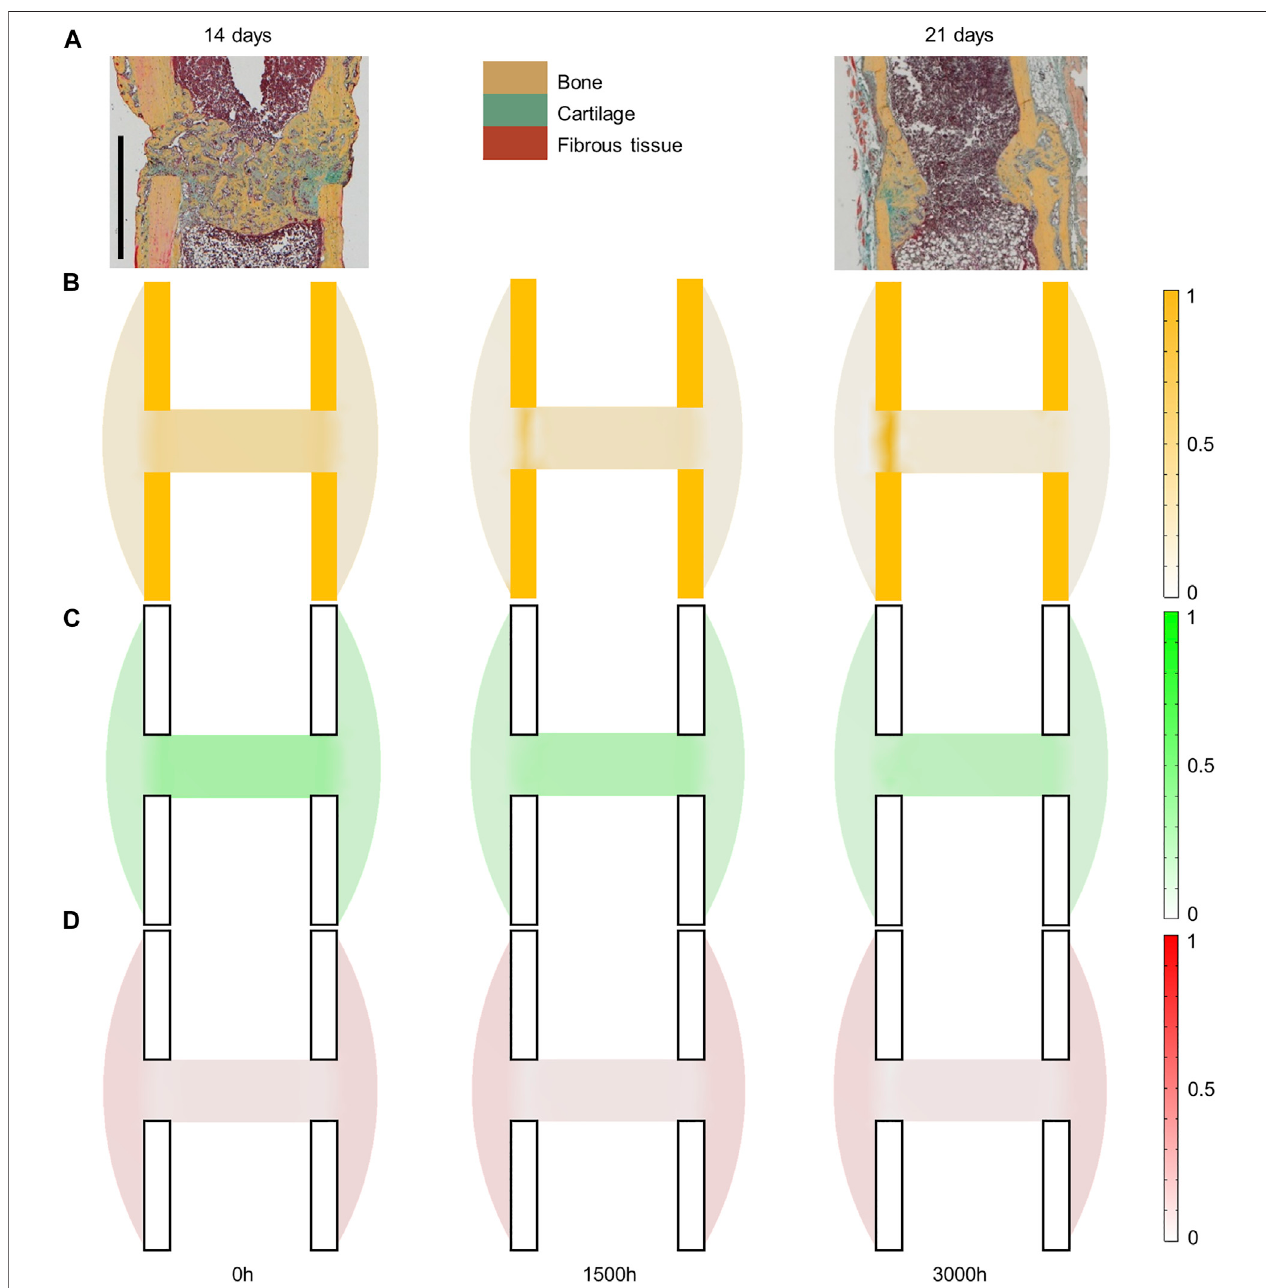
FIGURE 3 | Mouse fracture tissue distribution in the mid-sagittal plane: (A) experimental 14- and 21-day histology (image courtesy: Bettina Kruck); (B) predicted mature bone fraction at 0, 1,500 and 3000 h; (C) predicted mature cartilage fraction at 0, 1,500 and 3000 h; (D) predictedmature fi brous tissue fraction at 0, 1,500 and 3000 h. Scale bar: 1 mm; the fi xator was placed on the right of all images (medial side).